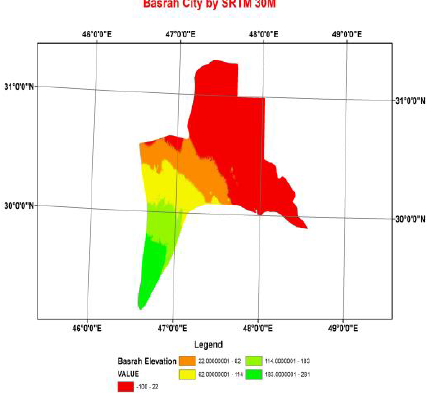
Figure 2. SRTM elevation model.